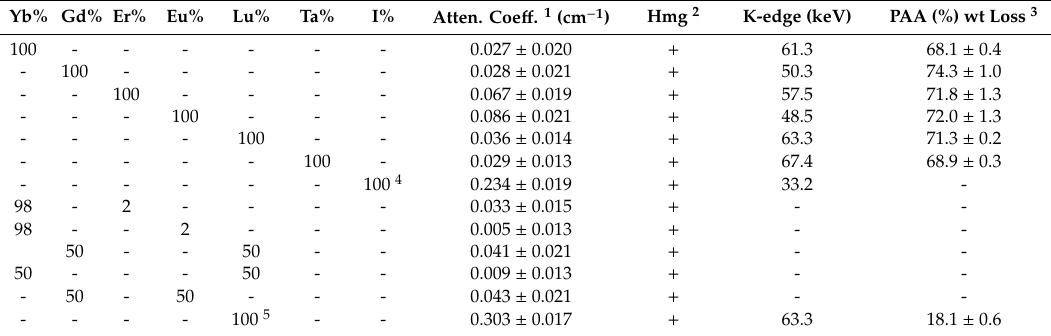
Table 2. CT values and characteristics of the di ff erent PAA-stabilized